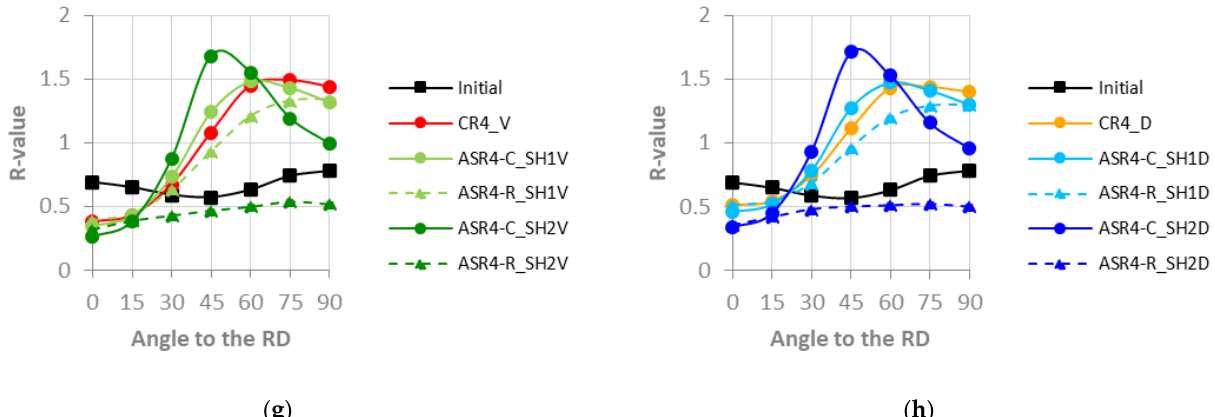
Figure 12. Simulated R -values of four-pass sequences rolling with a 20% thickness reduction per pass of CR, ASR-C, and ASR-R processes, considering two different amounts of shear strain, (SH1) and (SH2), for the: ( a ) 1st pass using a Voce-type hardening law (V); ( b ) 1st pass using the DDR model (D); ( c ) 2nd pass using a Voce-type hardening law; ( d ) 2nd pass using the DDR mode © ( e ) 3rd pass using a Voce-type hardening law; ( f ) 3rd pass using the DDR model; ( g ) 4th pass using a Voce-type hardening law; and ( h ) 4th pass using the DDR model.